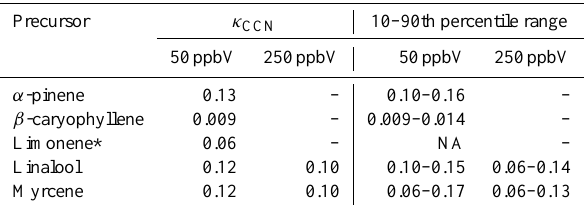
Table 4. Mean and range of kappa values derived from the CCNc measurements for the 50ppbV and 250ppbV initial precursor mix- ing ratios.